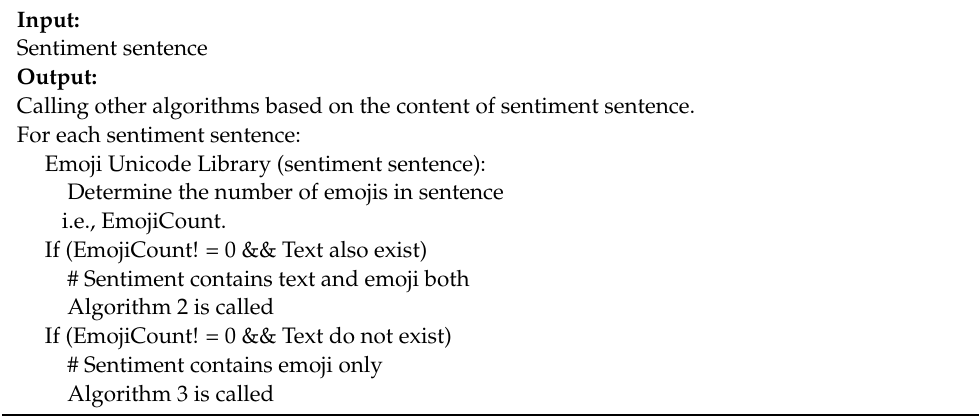
Algorithm 2: Sentiment containing both Text and Emoji